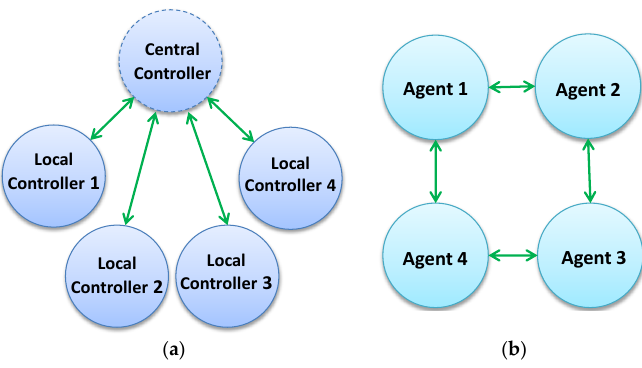
Figure 7. Communication topologies for two different control methodologies: ( a ) communication topology for centralized control; and ( b ) communication topology for multiagent based distributed control.